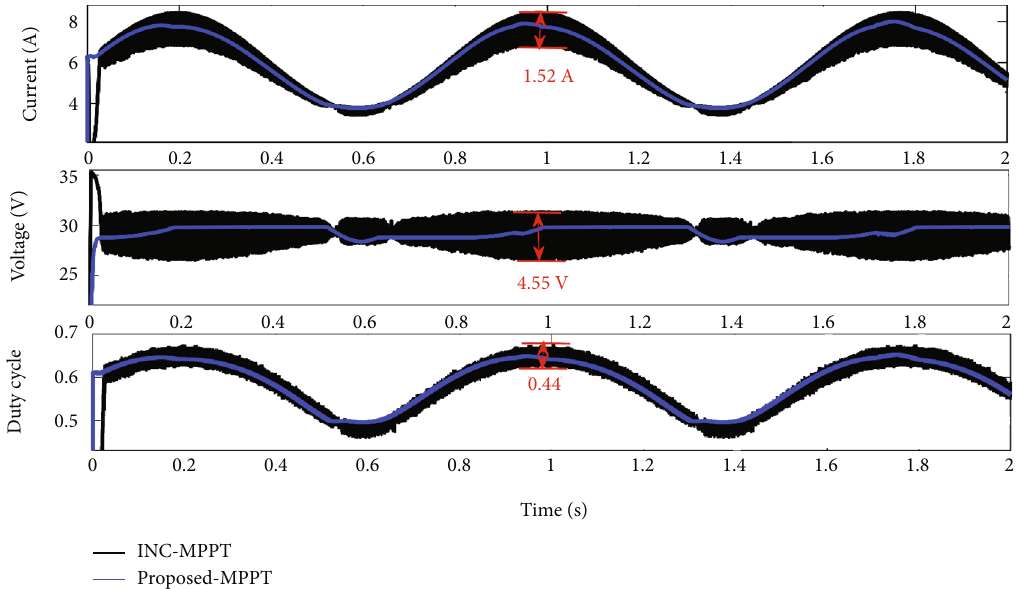
Figure 19: Photovoltaic output voltage and current with duty cycle of the boost converter